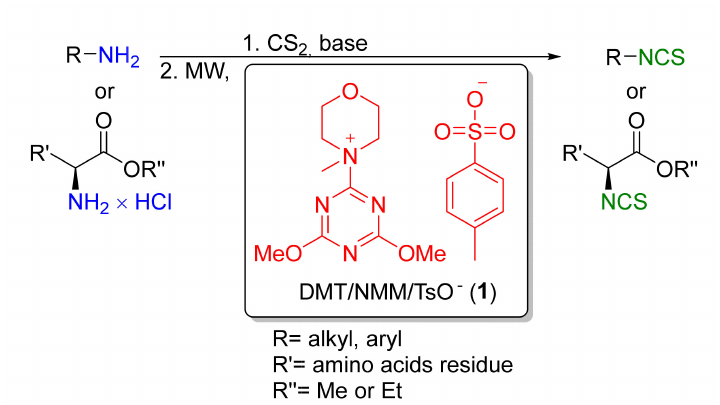
Figure 2. Synthesis of ITCs using DMT/NMM/TsO − ( 1